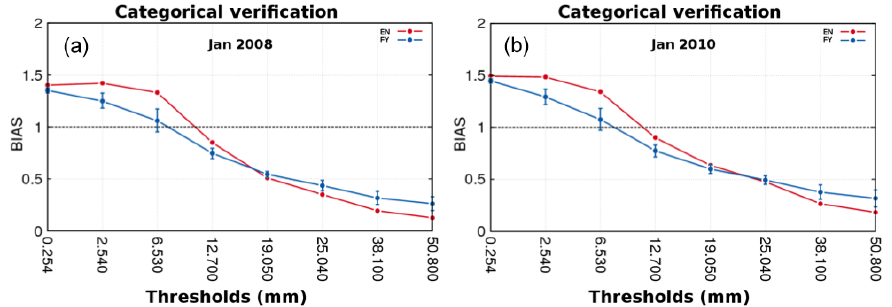
Figure 5. Mean bias score versus precipitation thresholds for South America for a set of 30 forecasts of 24h accumulated precipitation for 120h in advance for (a) January 2008 and (b) January 2010. Blue lines represent simulations using the FY weight method and red lines the original EN. The blue bars indicate the significance test from the bootstrap method (Hamill,